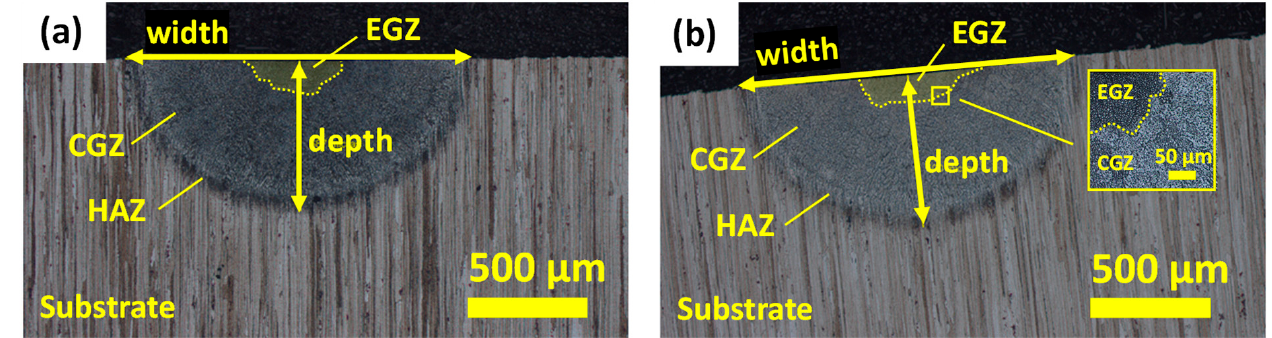
Figure 4. Optical images of the microstructure and measurements of the melt pool for treatment T1 in ( a ) initial and ( b ) final zones of the sample.